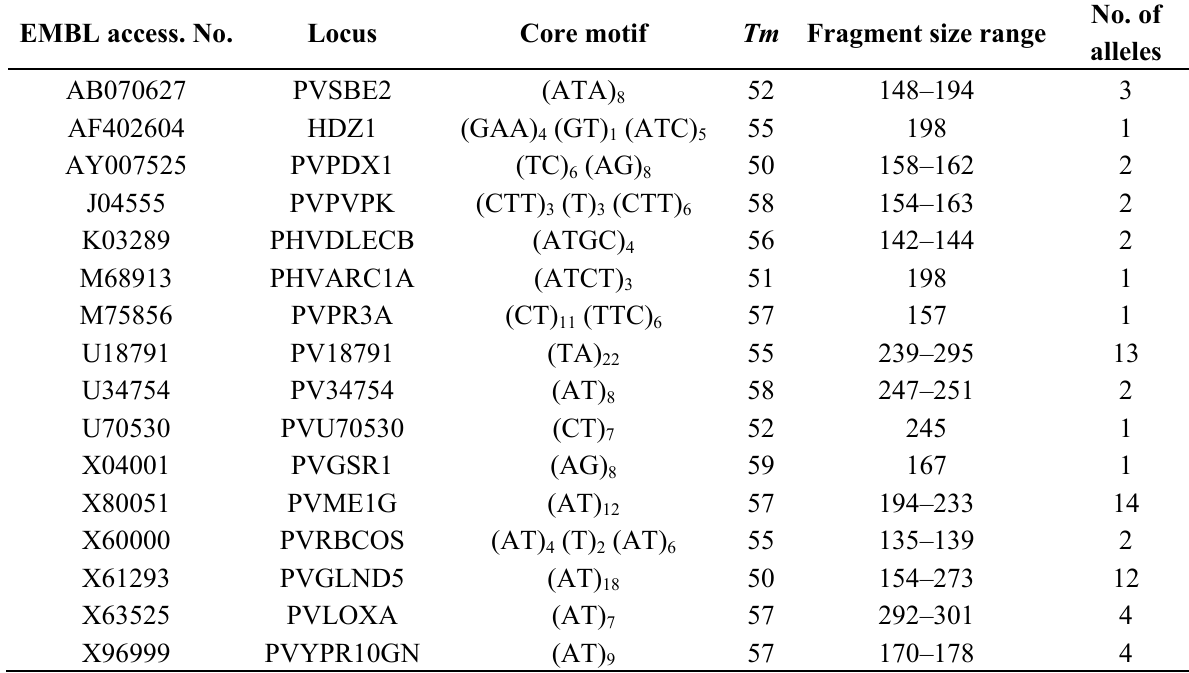
Table 1. List of 16 microsatellite loci of common bean identified in the European Molecular Biology Laboratory (EMBL) nucleotide database, temperature used ( Tm ), fragment size range, and number of alleles